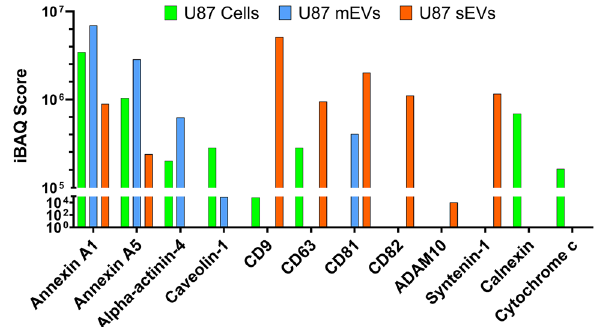
Figure 5. Identification of EV relevant markers in U87 cells and EVs by 1D-LCMS. The relative quantification is by intensity based absolute quantification (iBAQ). The absence of a bar indicates an iBAQ score of zero. A zero score indicates that the particular peptide was not observed in the sample or the software did not have the ability to quantify it from the local baseline